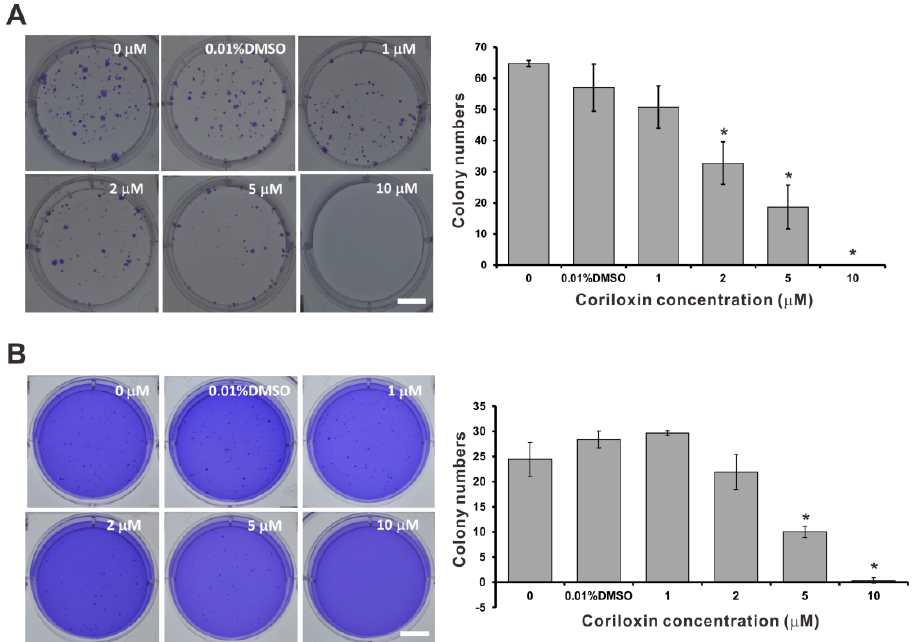
Figure 3. Anticlonogenic effects of coriloxin on CL1-5 cells. Representative images and integrated results of cells ( n = 4 per group) under the ( A ) anchorage-dependent and ( B ) anchorage-independent clonogenic assays are presented. The graphs summarize the analytical results. Values are reported as means ±SD ( n ≥ 3). * p < 0.05 indicates a significant difference from the solvent control group (0.01% DMSO). Scale bars, 1 cm.